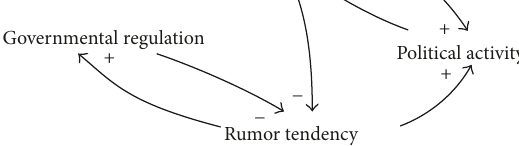
Figure 3: The governmental factors causal diagram.